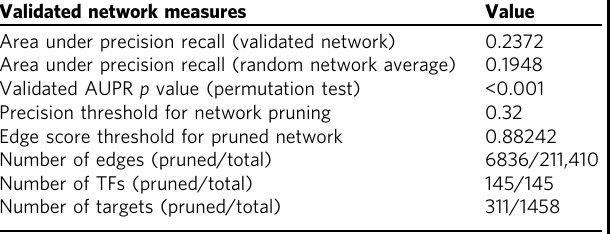
Table 2 Precision and recall pruning of a time-inferred network using TF – target